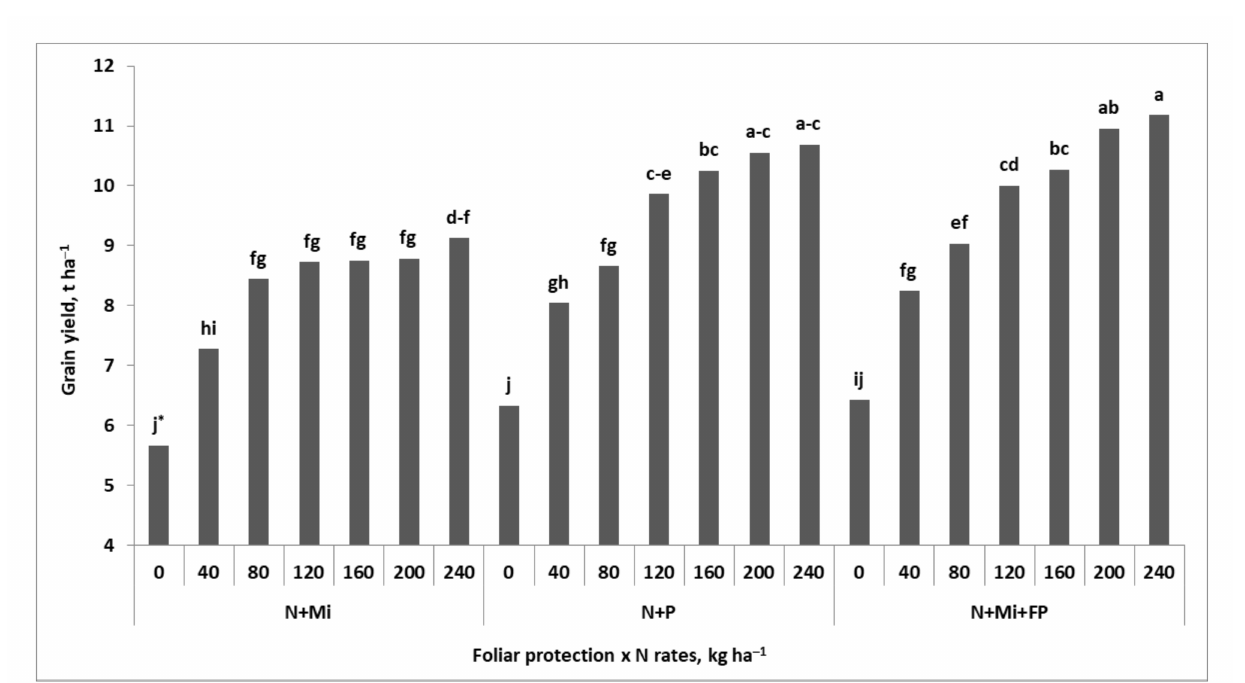
Figure 2. Response of winter wheat grain yield to interaction of foliar protection systems and N rates. * Similar letters means a lack of significant differences using Tukeys’ test. Legend: N + Mi—N